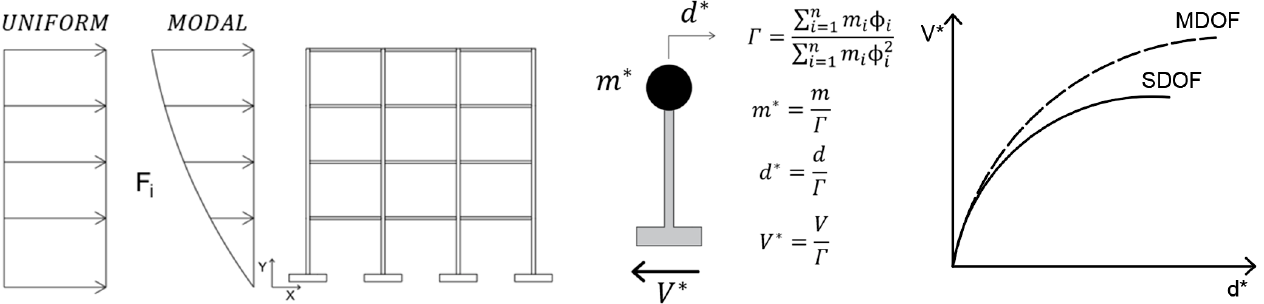
Figure 3. Determination of main frame capacity curves according to IBC.